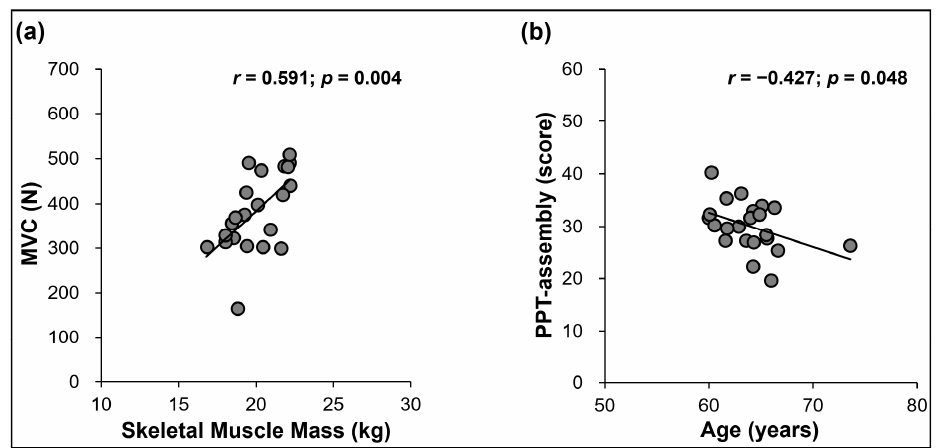
Figure 5. Correlation findings between skeletal muscle mass versus bimanual MVC and age versus PPT scores in bimanual assembly task for the older women group. ( a ) Lower levels of skeletal muscle mass were significantly related to less bimanual maximal forces. ( b ) Higher age was significantly related to lower bimanual PPT assembly scores.